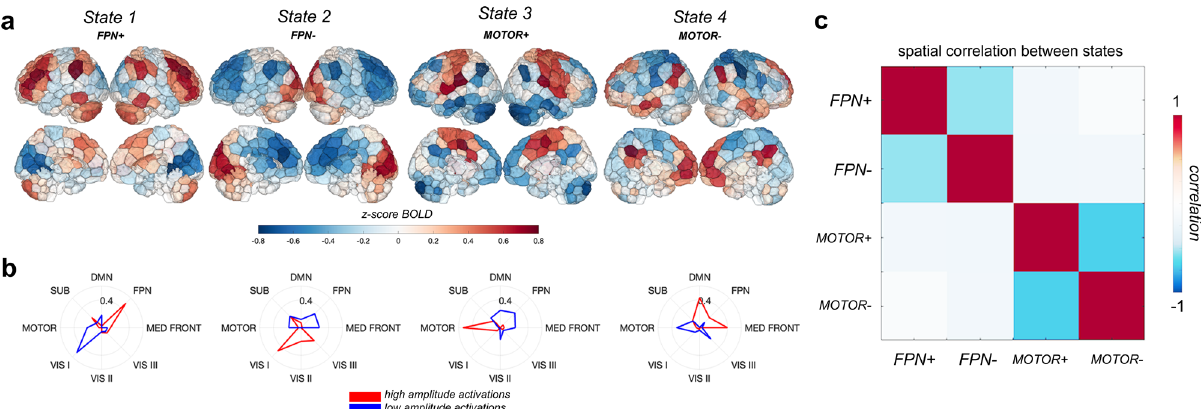
Fig. 2 Four brain activity states. a Centroids of each state calculated as the mean of the normalized regional activation over all TRs assigned to that state. b Radial plots displaying cosine similarity between each cluster and each canonical network; red indicates cosine similarity of the high amplitude activations, blue indicates cosine similarity of the low amplitude activations. Labels for each state were derived from analyzing the magnitude and type of overlap of each centroid with the 8 canonical networks. c Region-level correlation of each pair of brain state centroids. DMN default mode network, FPN frontoparietal network, MED FRONT medial frontal network, VIS III visual association network, VIS II visual network 2, VIS I visual network 1, MOTOR motor network, SUB subcortical/cerebellum